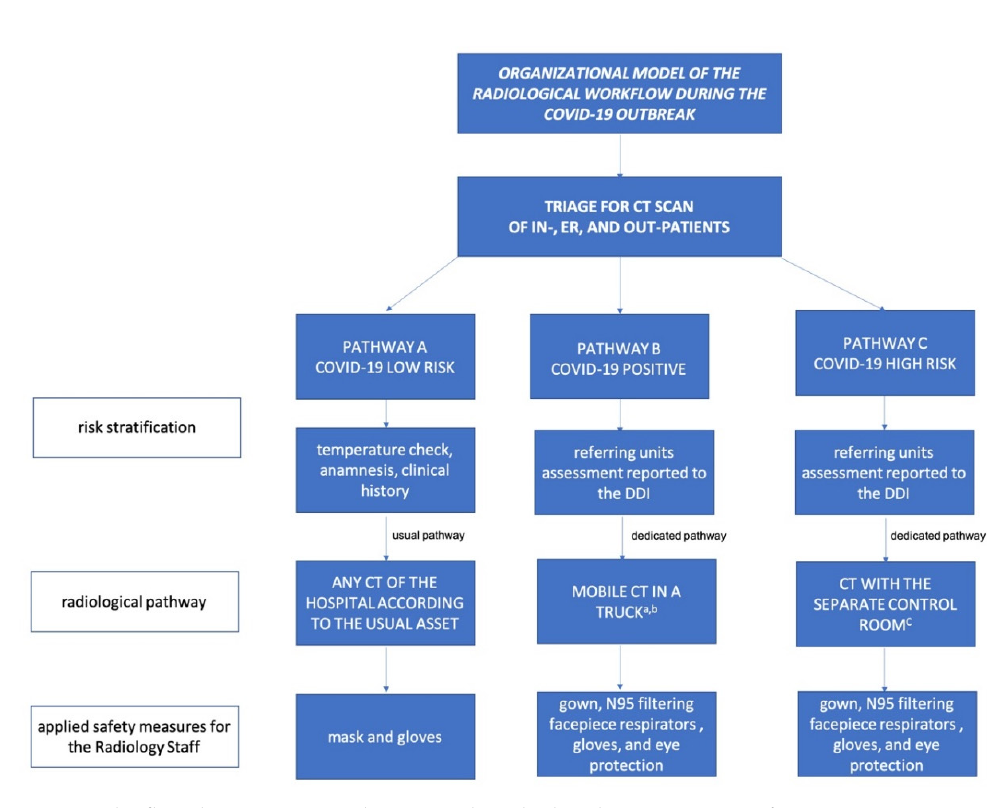
Figure 2. The flowchart represents the protocol applied in the Department of Diagnostic Imaging of the tertiary hospital of Padova to face the COVID ‐ 19 emergency. ( a rented since the beginning of the pandemic; b very critical who could have not been transported to the truck were scanned in the closest CT scanner; then, the room was sanitized and locked according to the guidelines; c then, the CT room was = Department of Diagnostic locked and cleaned according to the guidelines. DDI = Department of Diagnostic Imaging). was locked and cleaned according to the guidelines. DDI